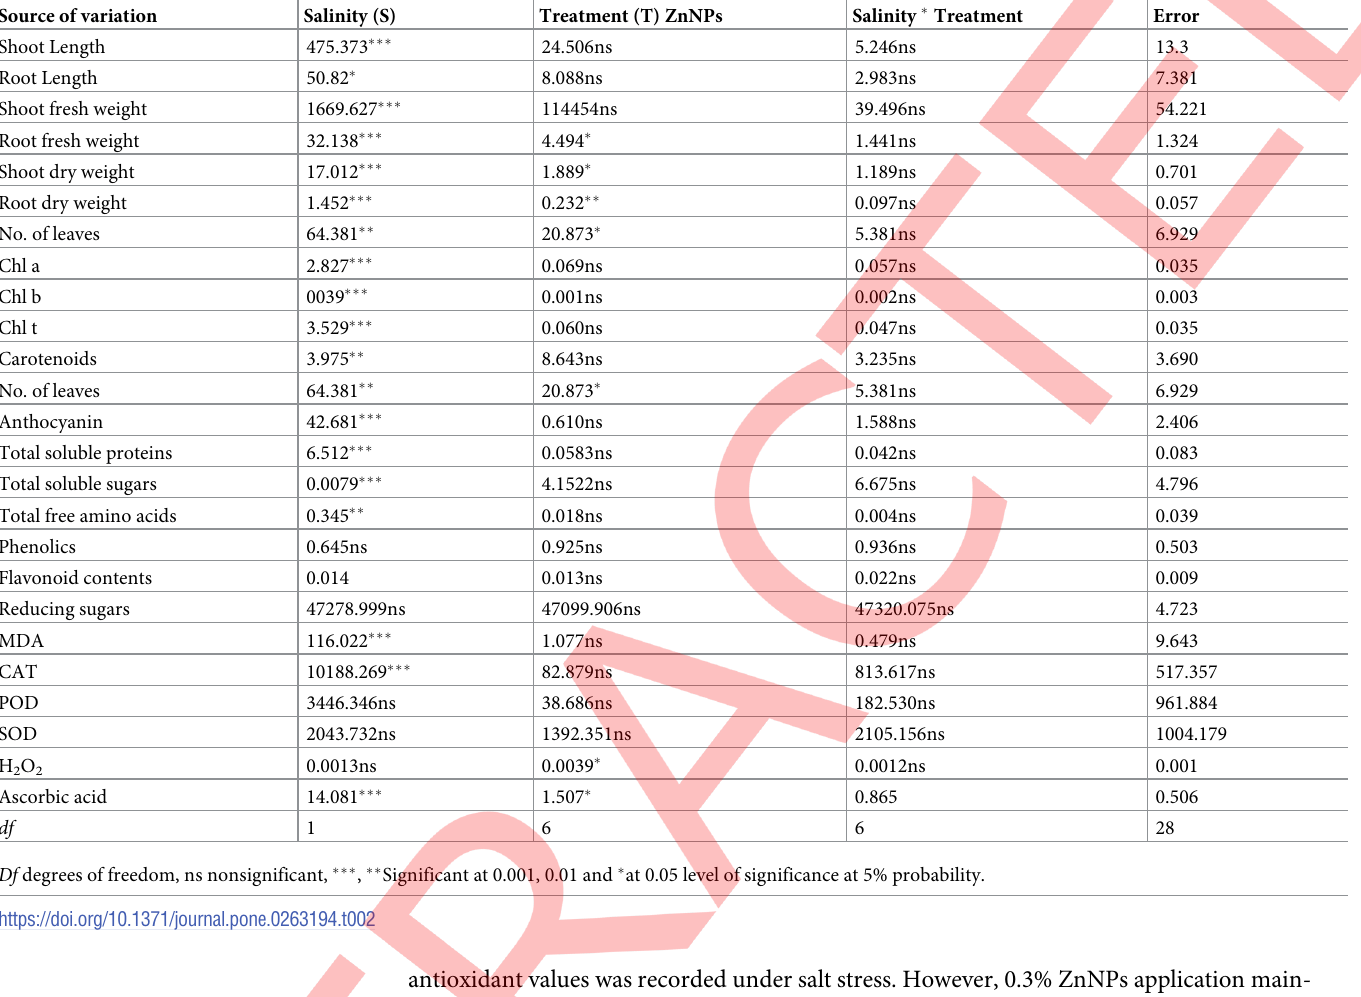
Table 2. Mean square values for biochemical and yield attributes of spinach ( Spinaceae oleraceae L.) plants with priming and foliar application of ZnNPs under saline